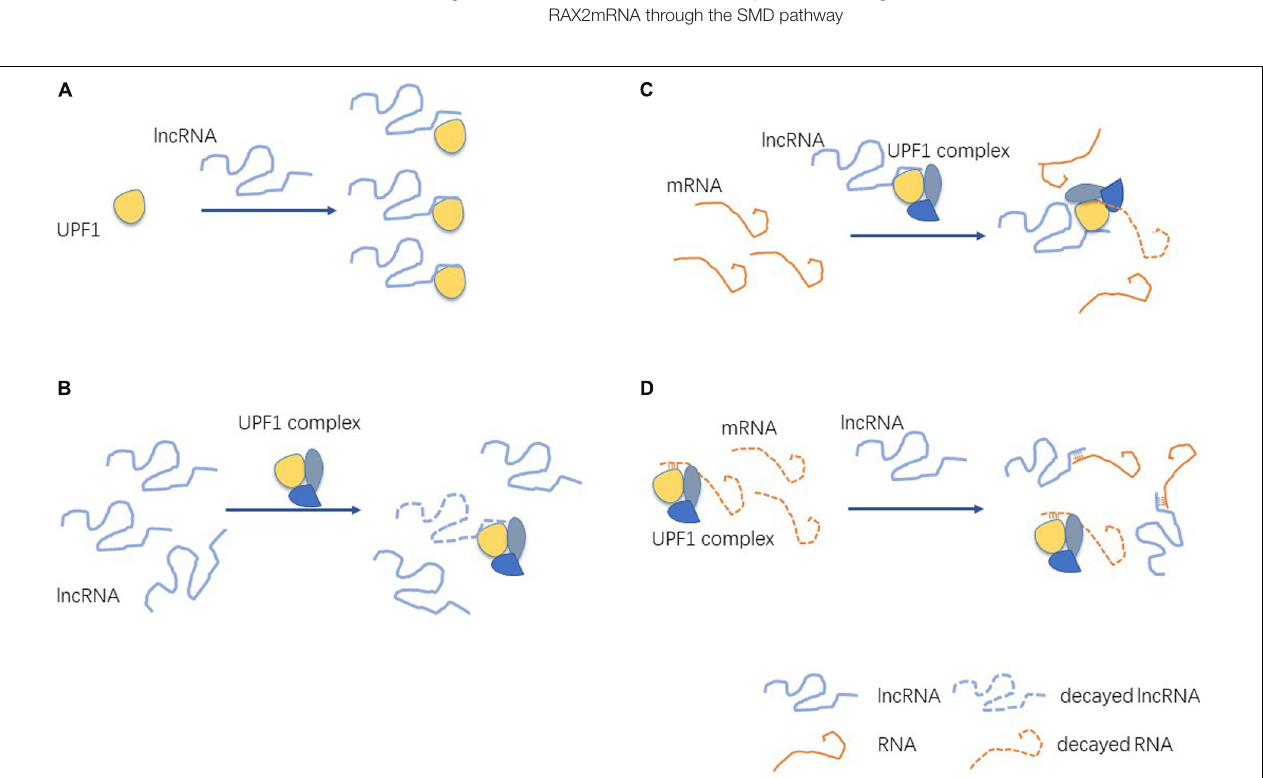
FIGURE 3 | Mechanisms of lncRNA interactions with UPF1. (A) lncRNAs bind UPF1 and affect the expression of UPF1. (B) lncRNAs bind UPF1 and affect the stability of mRNA. (C) UPF1 binds lncRNAs and affects the expression of lncRNAs. (D) UPF1 and lncRNA competitively bind mRNA.